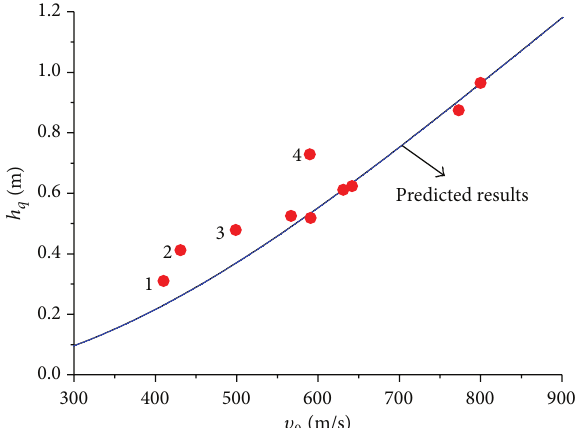
Figure 14: The experimental results [29] and predicted penetration